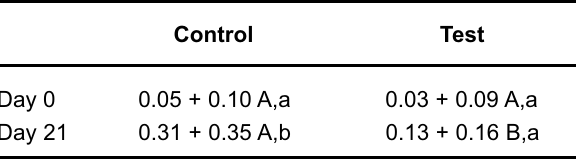
Means followed by the same uppercase letters on day 0 and day 21 do not differ statistically (p>0.05). Means followed by different lowercase letters in the same column differ statistically (p<0.01).